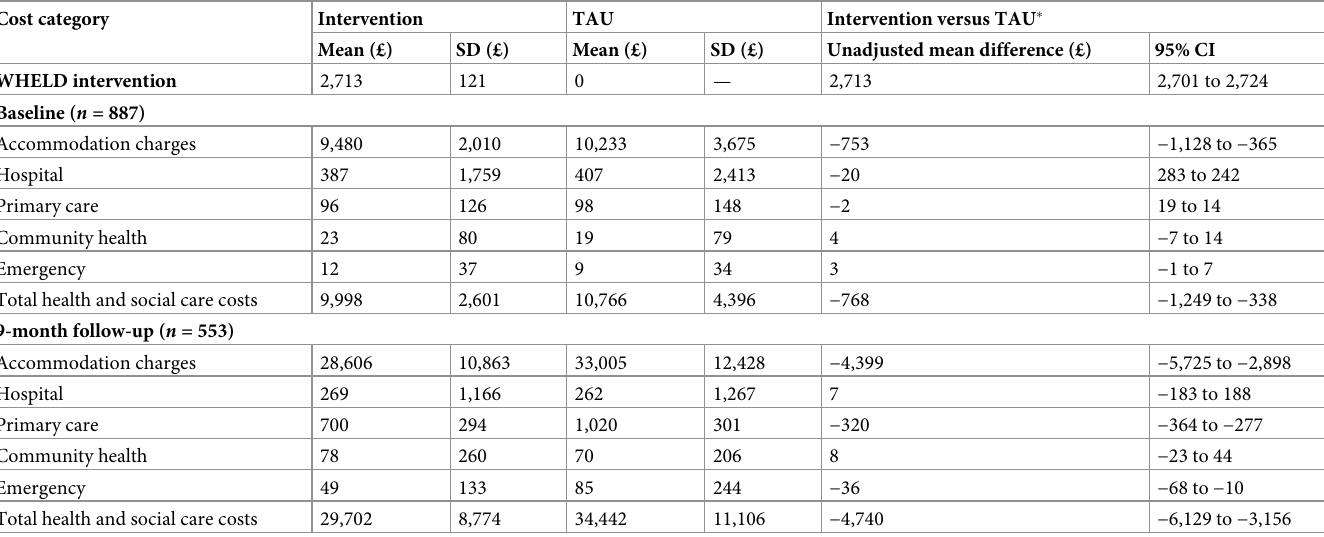
(cid:3) Cost comparisons for 9 months include covariates for site, age, baseline CMAI score, and baseline value of the same cost variable. Baseline cost comparisons include covariates for site, age, and baseline CMAI score. CMAI, Cohen-Mansfield Agitation Inventory; TAU, treatment as